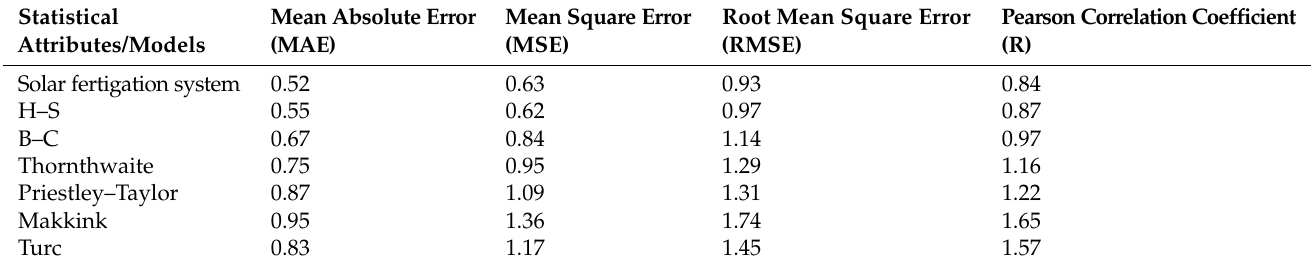
Table 3. Mean statistical attributes estimated by temperature- and radiation-based models compared with the standard combination-based FAO P–M model in Molise region over the study period from